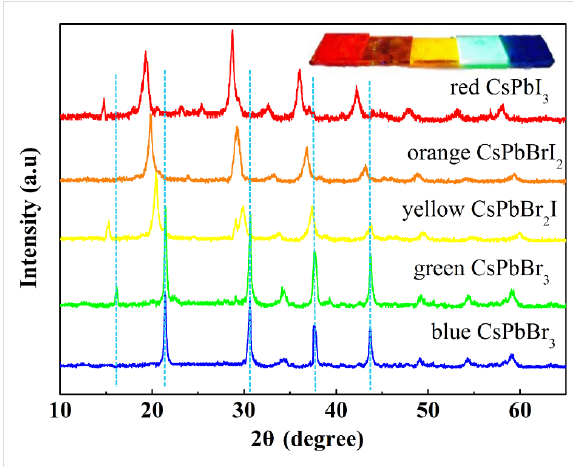
Figure 3: X-ray diffraction patterns of CsPbX 3 quantum dots of five dif- ferent colors.